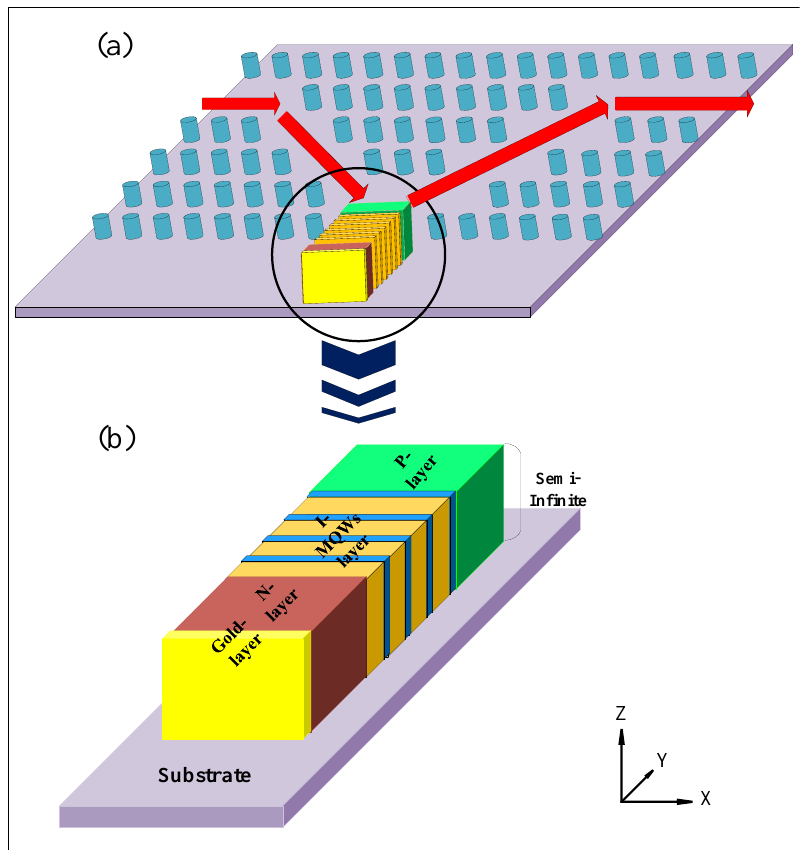
Figure 4. ( a ) Three-dimensional structure of the modulator including PhC waveguide and p-i-n modulator. ( b ) The structure and arrangement of the electronic part of the modulator